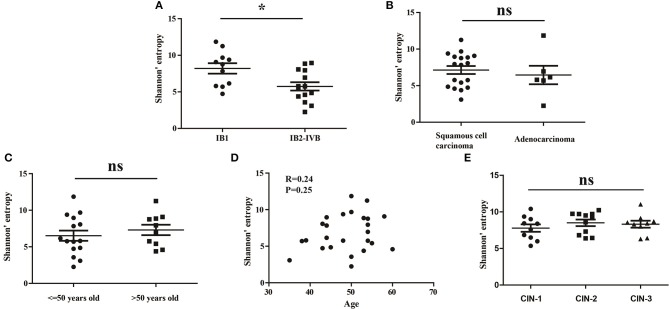
The Shannon's entropy of peripheral blood TCR repertoire between different subgroups in CC or CIN patients. Comparison of the Shannon's entropy (A) between the early and advance CC patient subgroups, (B) between the squamous cell carcinoma and adenocarcinoma subgroups, and (C) between age > 50 and age ≤ 50 years old subgroups for CC patients. *P < 0.05, ns, no significant difference, t-test. (D) The correlation between age and Shannon's entropy in CC patients, Pearson correlation test. (E) Comparison of the Shannon's entropy in peripheral blood TCR repertoire among CIN1, CIN2, and CIN3 subgroups. ns, no significant difference, one-way ANOVA test.